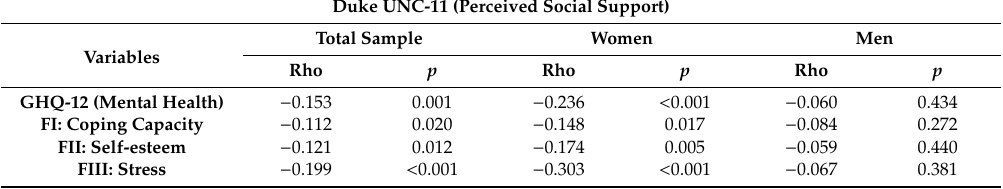
Table 6. Relationship between the dimensions and subscales of the Goldberg General Health Questionnaire GHQ-12 and the Duke-UNC-11 Functional Social Support Questionnaire in older caregivers. Spain,